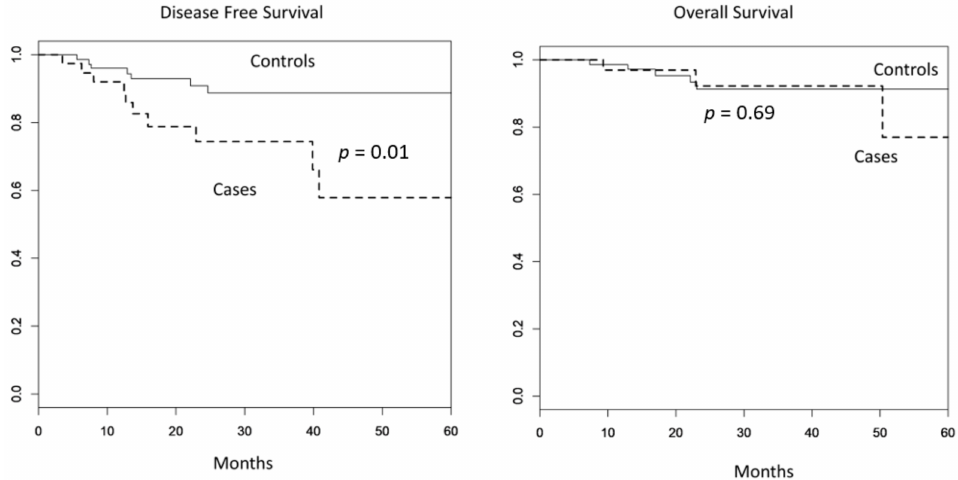
Figure 1. Disease-free survival (DFS) and overall survival (OS) in cases (ADs) and controls (no ADs). DFS at 2 years in cases: 74%, DFS at 2 years in controls: 91% ( p = 0.01). OS at 2 years in cases: 92%, OS at 2 years in controls: 91% ( p =